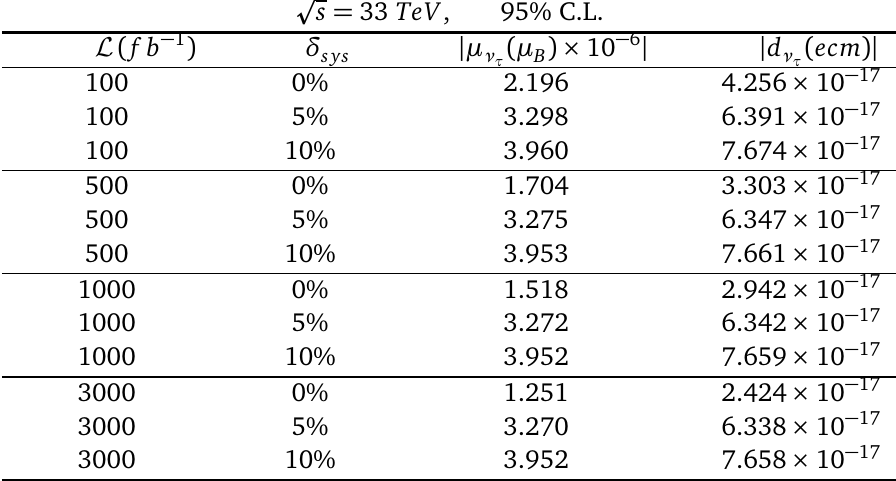
Figure 4: Same as in Fig. 2, but for Table 1: Sensitivity on the µ ν magnetic moment and the d ν (cid:112) τ s = 33 TeV and L = 100,500,1000,3000 f b − 1 at 95% C.L. through the process for pp → ν τ ¯ ν τ γ + X